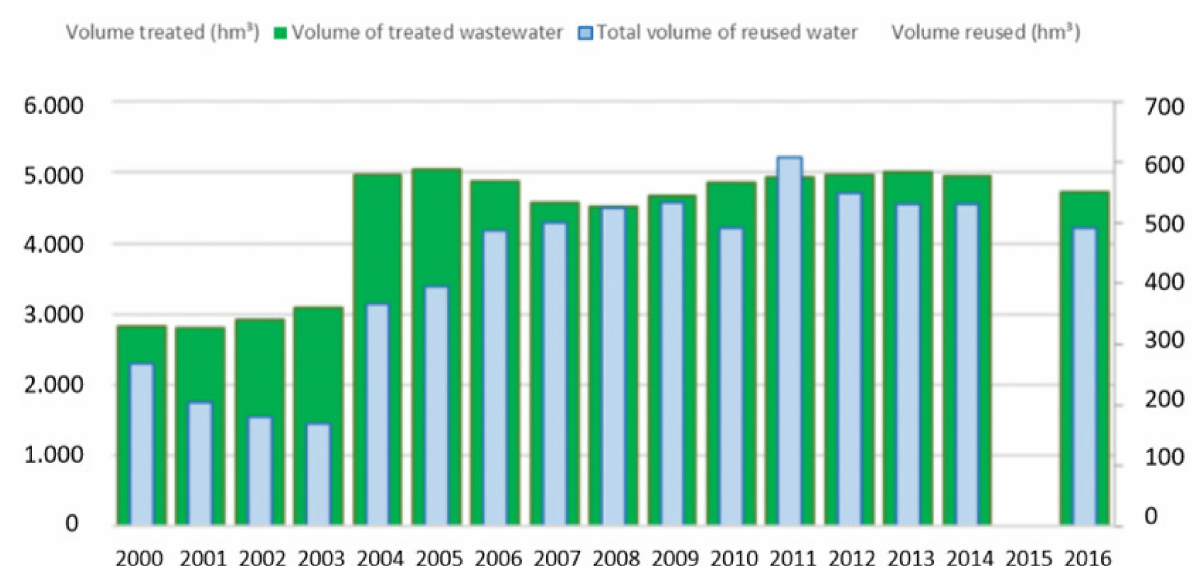
Figure 2. Evolution of the volume of wastewater collection (green) and treated water reuse (blue) in Spain. Source: Spanish DSEAR Plan draft,